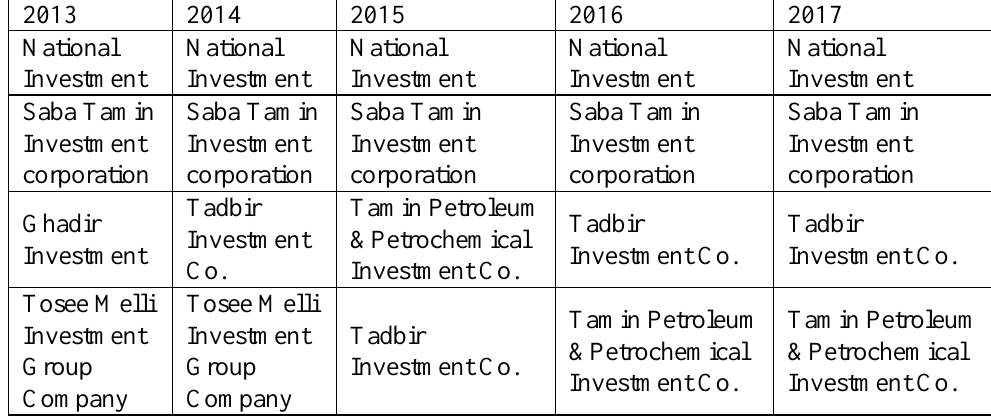
Table 7. shareholders related to the maximum betweenness